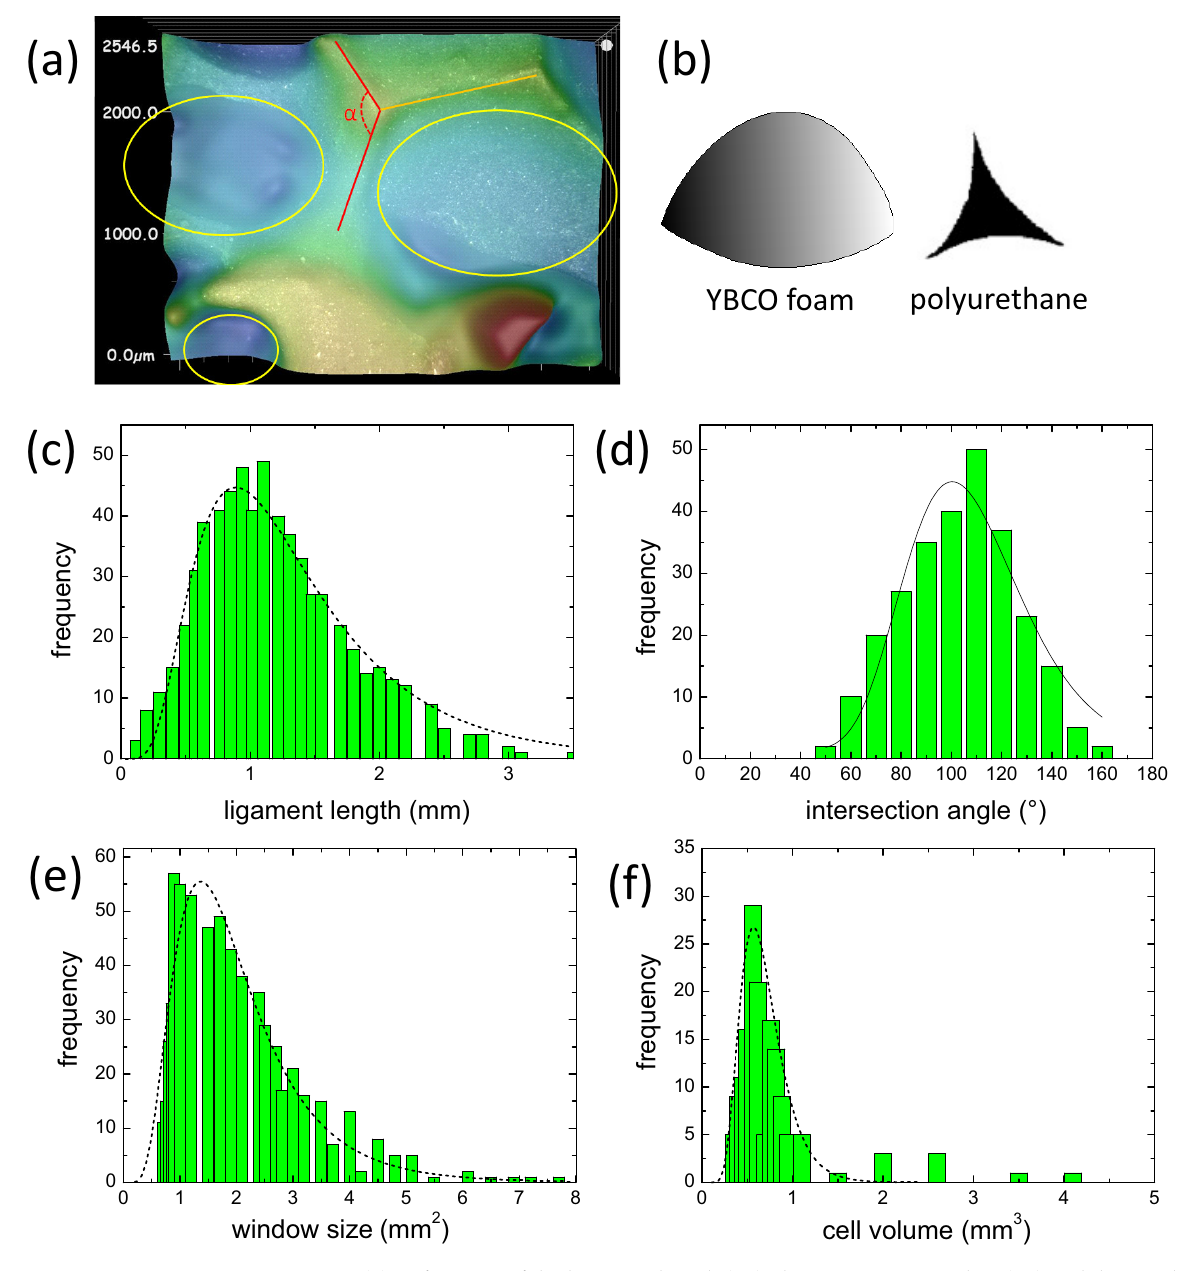
Figure 7. ( a ) Definitions of the ligament length ( ), the intersection angle α ( ) and the window size (yellow ellipses). ( b ) presents the typical cross section found by profile analysis for the YBCO foam (left) compared to a sketch of the cross section following Jang et al. [22]. ( c – f ) Statistical distribution analysis of the ligament (strut) lengths, the window size, the intersection angles and the cell size. The black dashed lines indicate log-normal fits to the data, and a normal fit in ( d